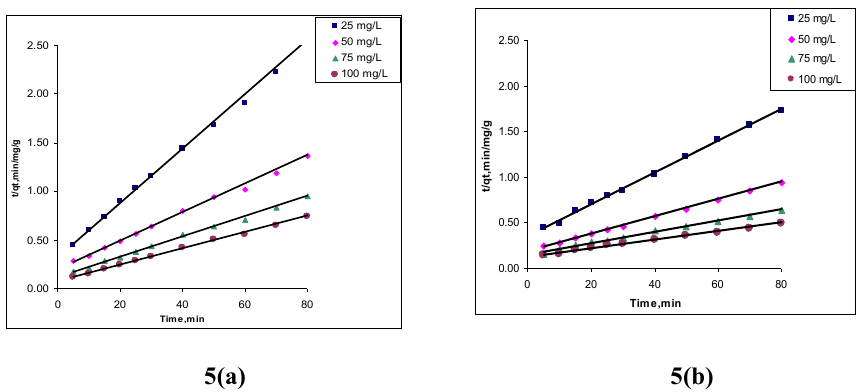
Figure 5. Pseudo second order plots for the adsorption of DB 71 dye onto TPAC and PPC at 30° C (adsorbent dosage, 100mg; pH,